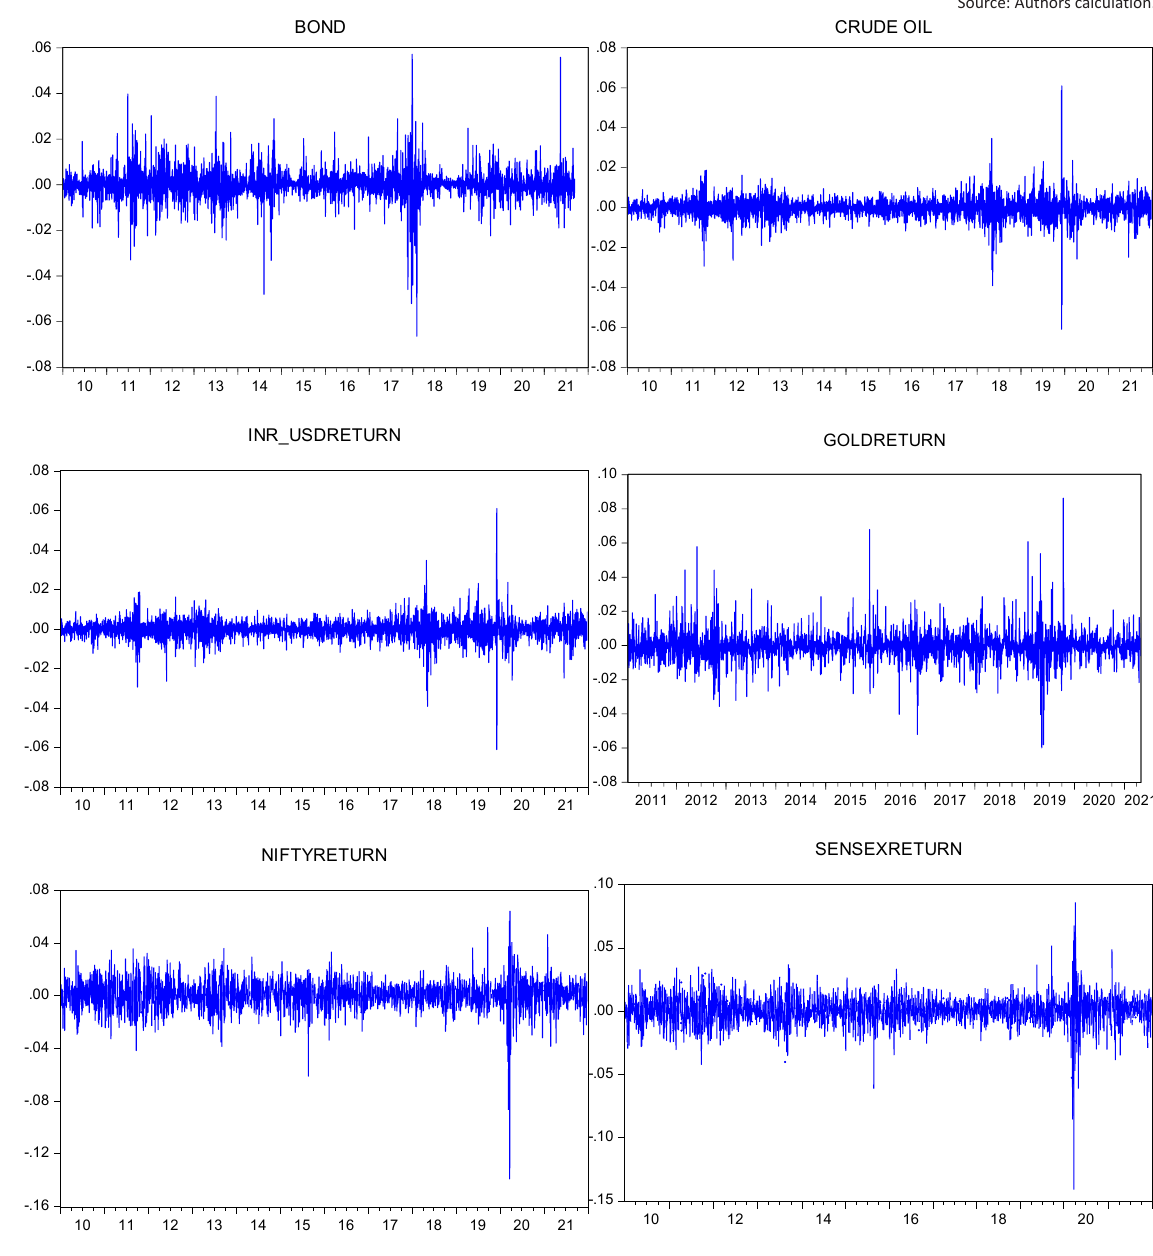
Figure 1. Return plot of financial